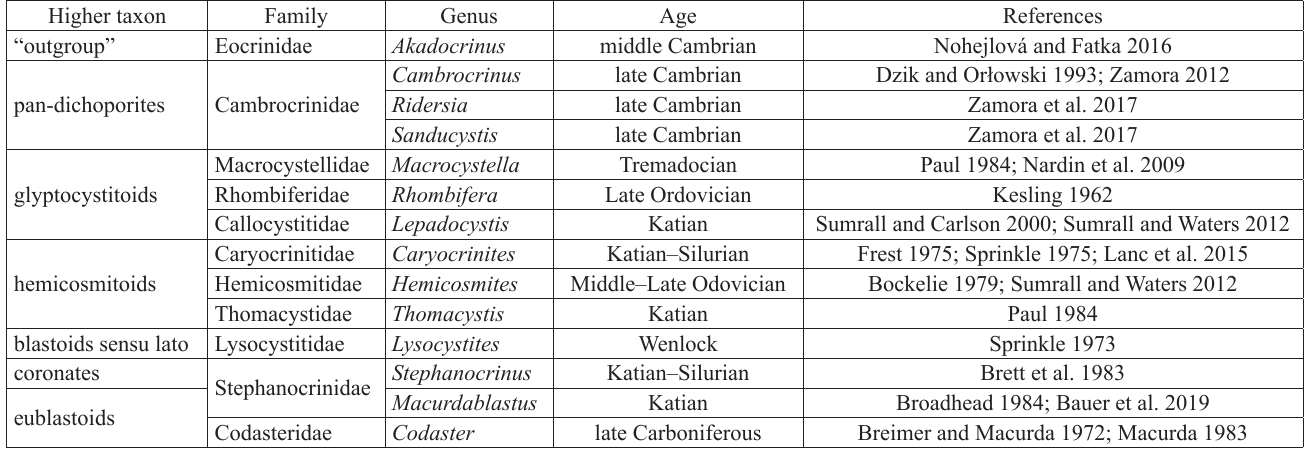
Table 1. Key genera discussed in the text. Higher taxon